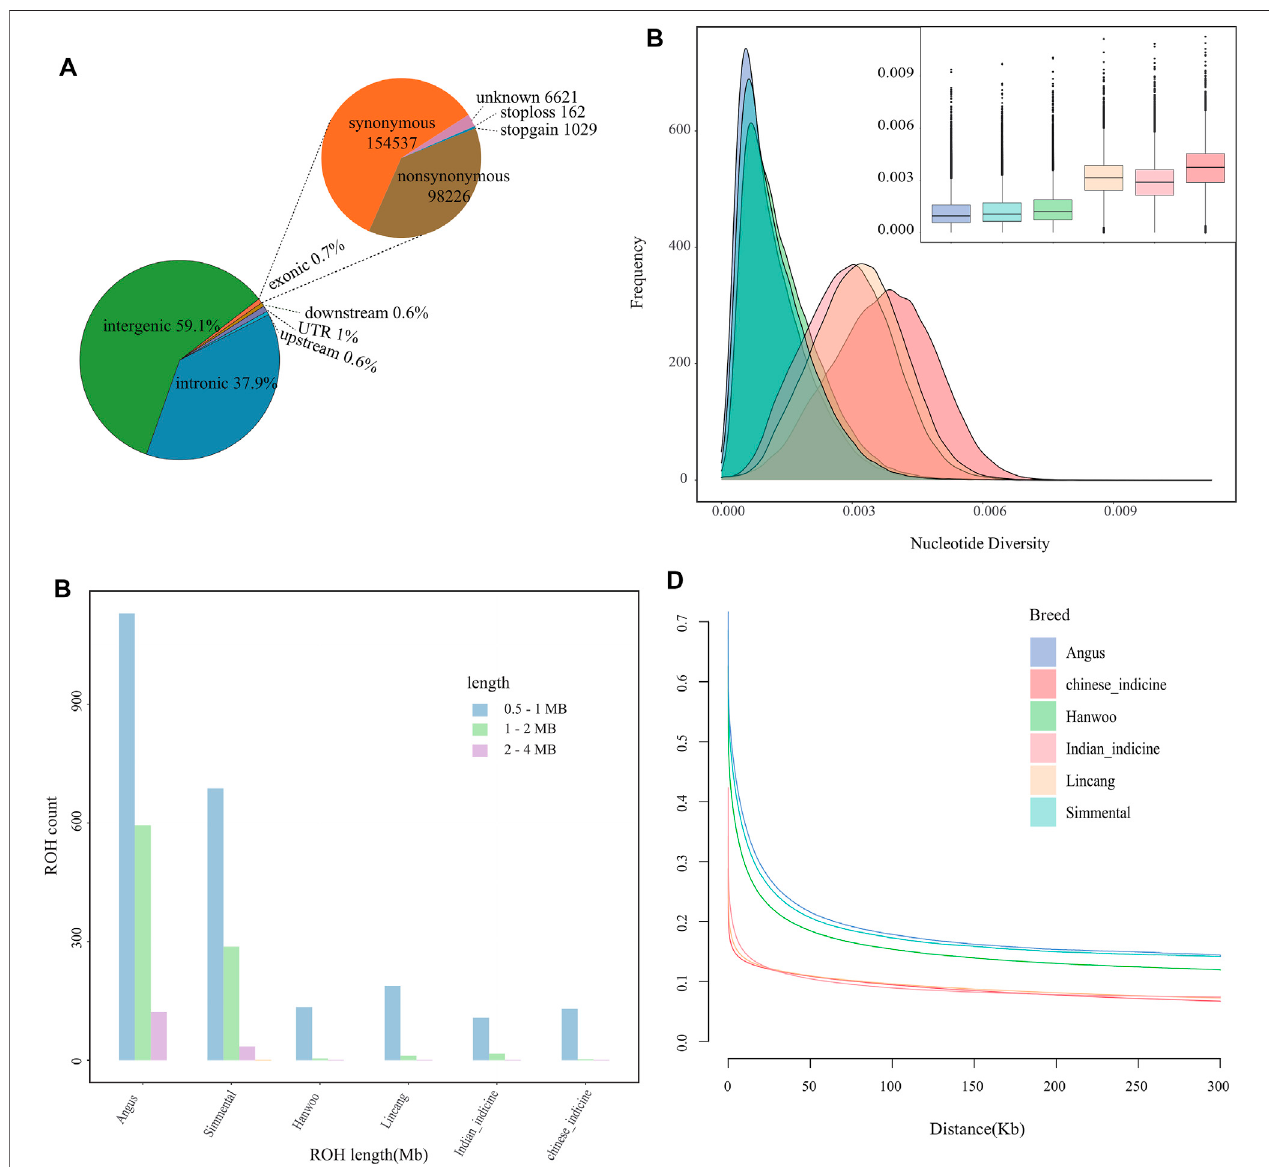
FIGURE 1 | Genomic characteristics of cattle population. (A) Functional classi fi cation of the detected SNPs in Lincang cattle. (B) The estimation of number and length of ROH for each group. (C) Estimated nucleotide diversity for each group. (D) Linkage disequilibrium (r2) decay on cattle autosomes estimated from each group.